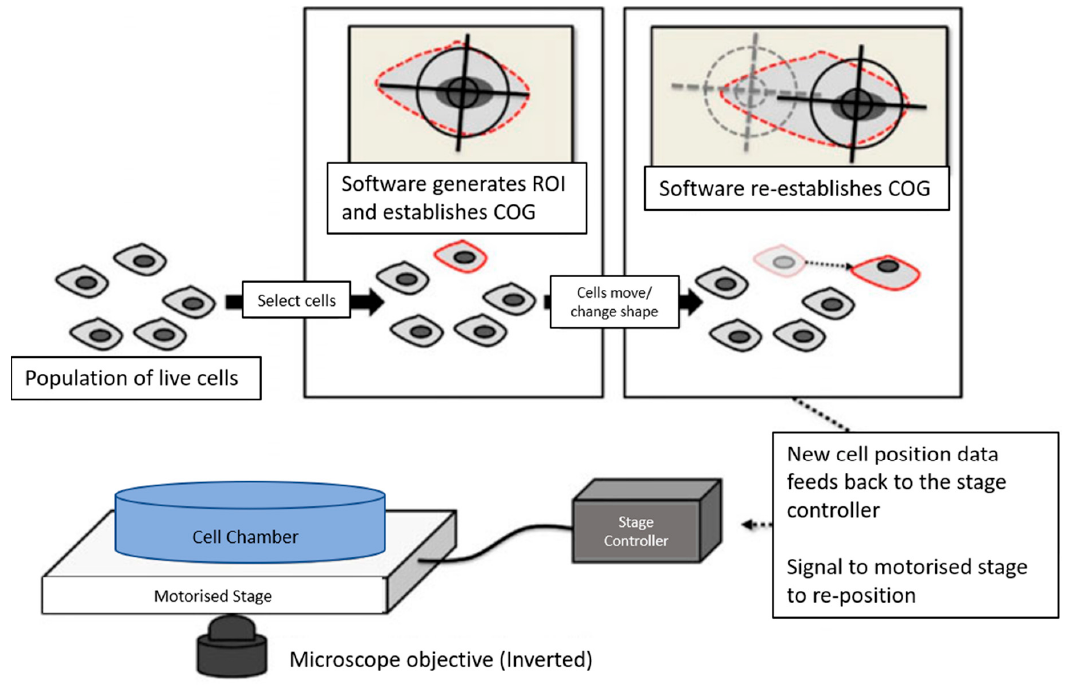
Figure 27. Tracking of individual cells from a population of live culturing cells using a live-cell imaging microscopic platform with a high-resolution micro-displacement motorized stage. “Reprinted with permission from [202]. Copyright (2016) Springer Nature”.